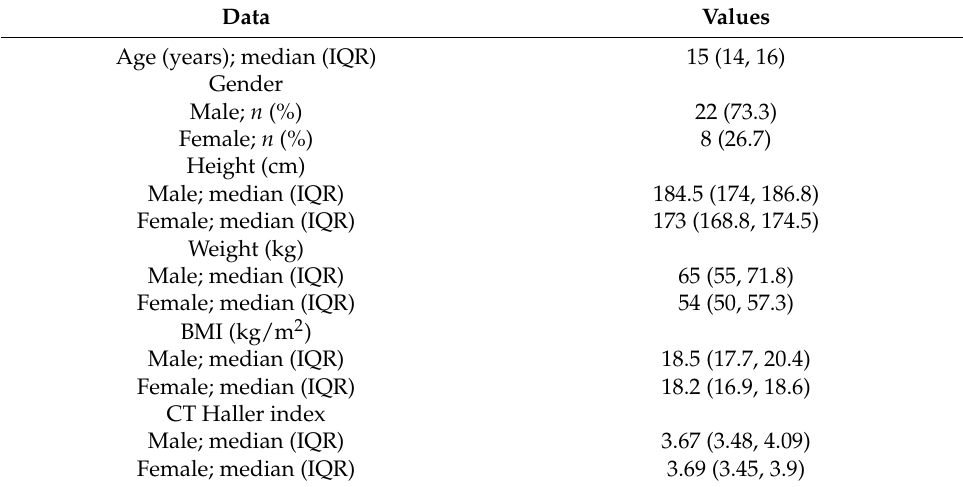
Table 1. Demographic data of the patients.